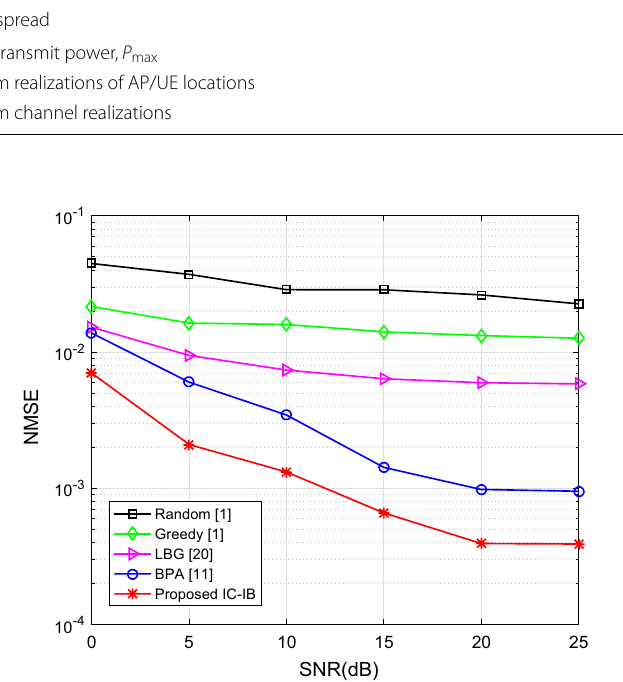
Fig. 2 NMSE of channel estimation with various received signal-to-noise ratio (SNR) for different pilot assignment schemes with M = 8, N = 30, K = 20 and τ p =